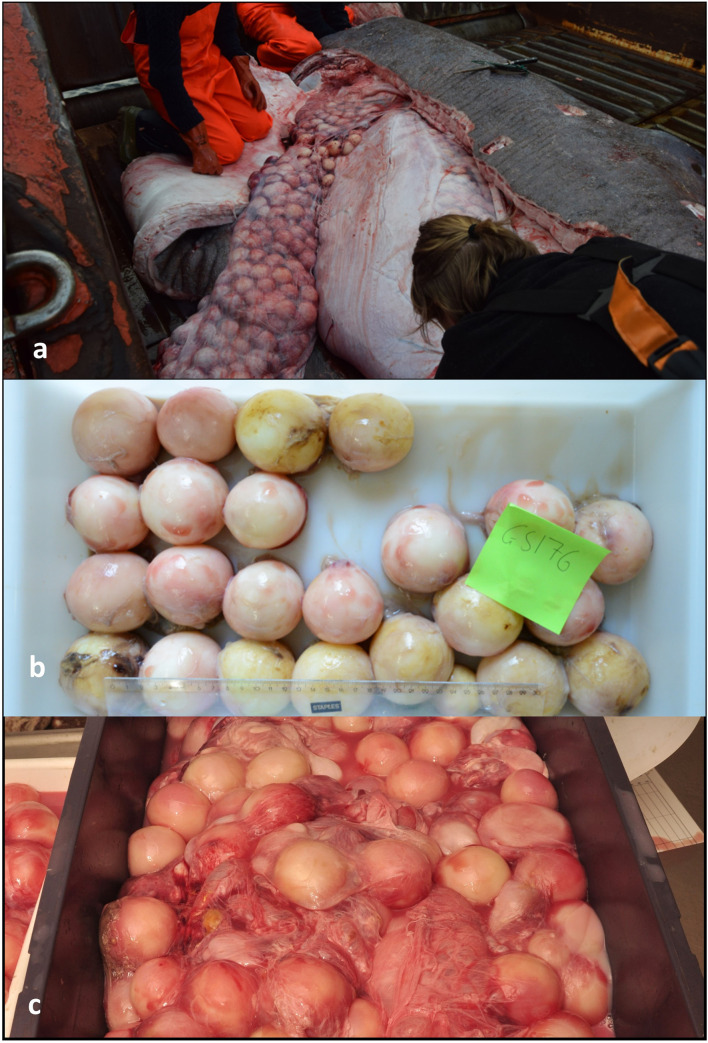
Ripening ova.(a+b) similar sized ripe/ripening ova up to 6.0 cm in diameter of Shark no. 128. (c) ripe/ripening ova up to 7.0 cm in diameter of Shark no. 132 as well as a few smaller ova (<1.5 cm) that were not counted.